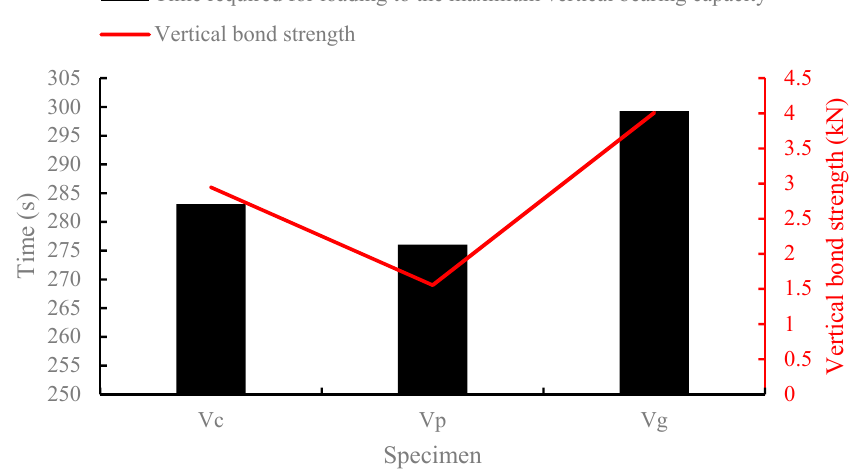
Figure 21. Comparison of the vertical bonding strength of different specimens and the time required to measure the maximum vertical bearing capacity.